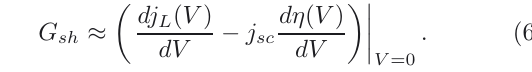
Fig. 1. Illuminated (blue) curves for different illumination in- tensities j E and dark curve (black) in combination with the computed current density of the fit (red). The inset at the up- per left side magnifies the illuminated curves being very close to each other and clarifies the procedure for determining the noise level of j L . The red line is j linear ( V